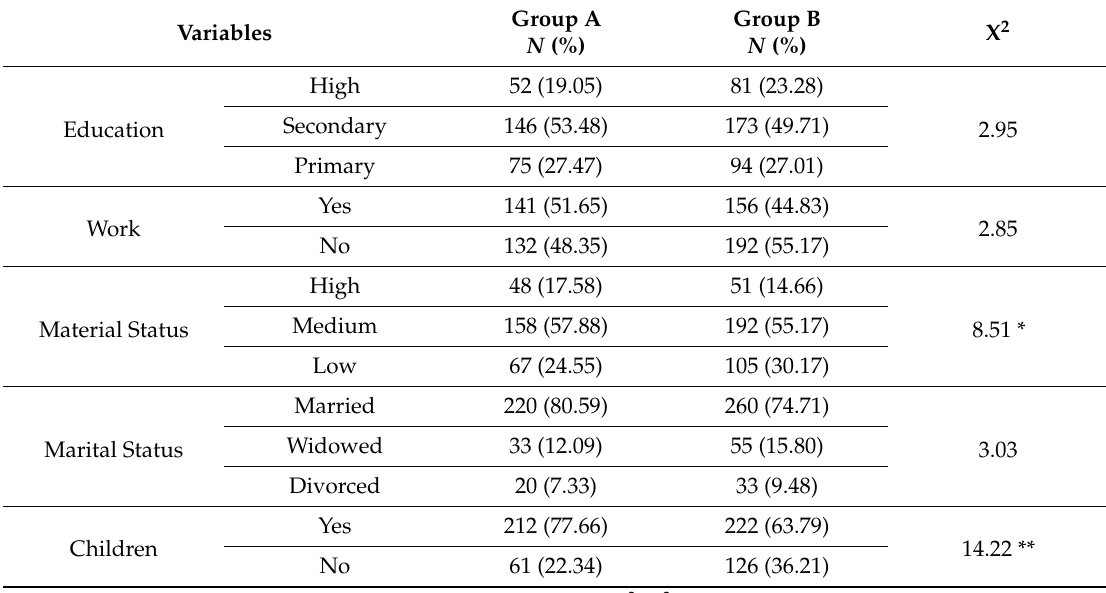
Table 1. Distribution of the groups researched according to sociodemographic